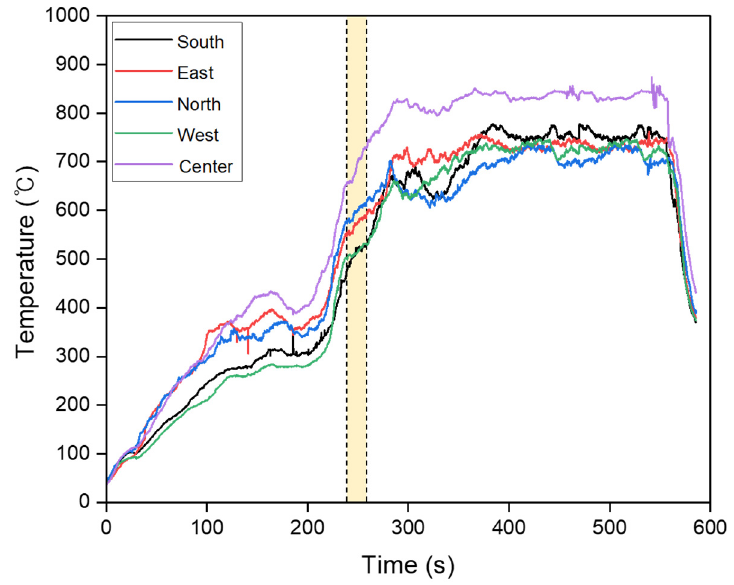
Figure 3. Temperature of the thermocouples over time. All wires were short-circuited within the yellow region (680–750 °C).